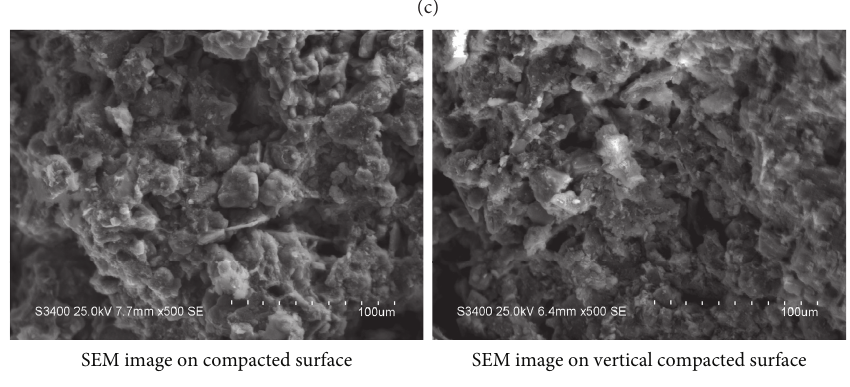
� 1.60g/cm 3 . (c) ρ d